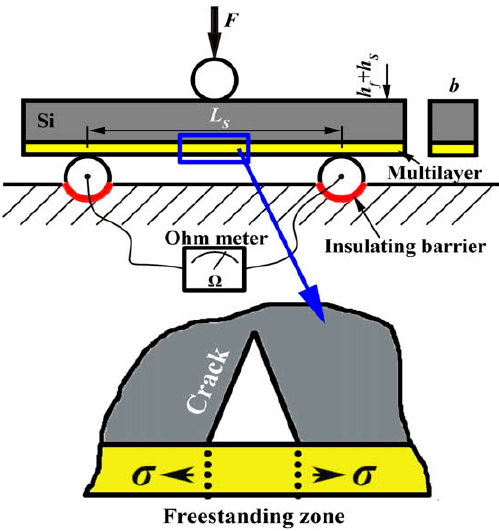
Figure 10. Schematic illustration of three-point bending apparatus used for localized fracture experiment [67].